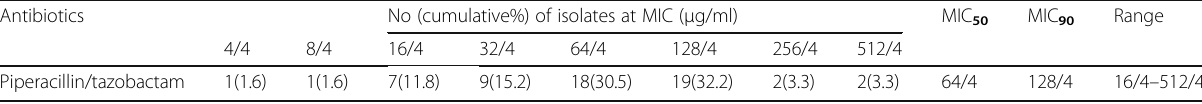
Table 5 MIC distributions for piperacillin/tazobactam antibiotic against 59 carbapenem resistant P. aeruginosa isolates Antibiotics